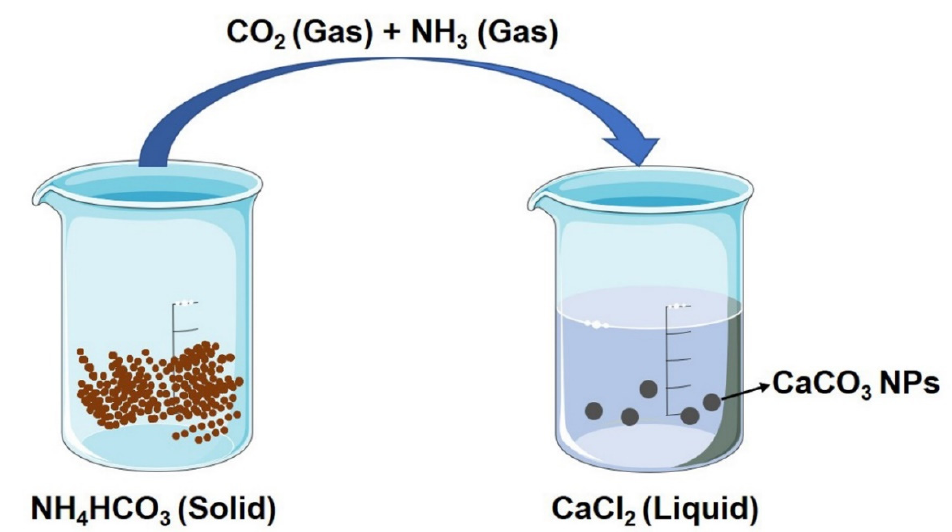
Figure 1. Illustration of the gas diffusion method. CO 2 and NH 3 were generated from ammonium bicarbonate, which then dissolved in the ethanol solution and reacted with Ca 2+ to form CaCO 3 NPs.